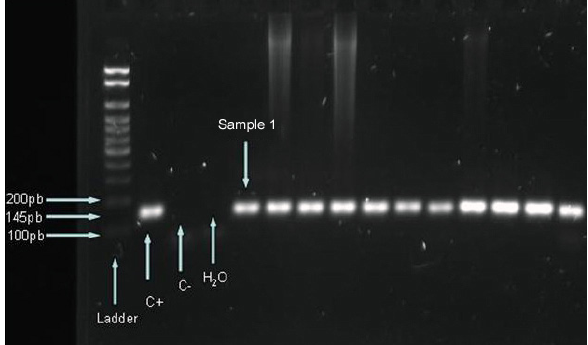
Figure 1. Gel electrophoresis presenting 145 base pair bands amplified by RV1 and RV2 primers.